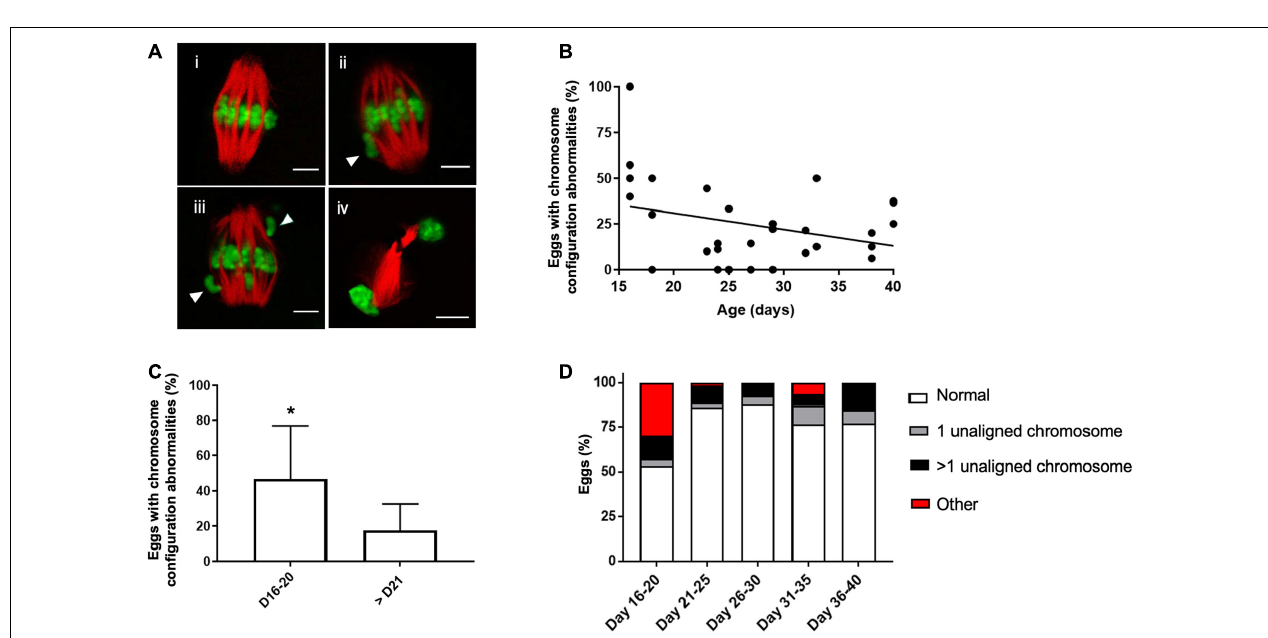
FIGURE 4 | Abnormal meiotic chromosome configurations are more prevalent in the youngest age cohort. (A) Representative confocal images of how different chromosome configurations observed in MII eggs were categorized: (i) normal bipolar spindle with chromosomes aligned on the metaphase plate (ii) spindle with 1 misaligned chromosome (arrowhead), (iii) spindle with ( > 1 misaligned chromosomes (arrowheads), and (iv) a telophase I spindle indicative of cell cycle delay. The scale bar is 5 µ m. (B) The correlation between mouse age and the percentage of eggs with abnormal chromosome configurations ( n = 244 eggs from 4 to 8 mice per age cohort). Line was fit to the data ( r = − 0.22, p = 0.23). (C) The average incidence of chromosomal abnormalities in MII eggs per mouse in the PND 16–20 was plotted relative to the other ages in aggregate. Asterisk denotes significant difference between the groups ( p < 0.01, n = 244 eggs from 4 to 8 mice per age cohort). (D) Percentage of MII eggs with specific chromosome configuration abnormalities was plotted in each age cohort according to the criteria established in (A)